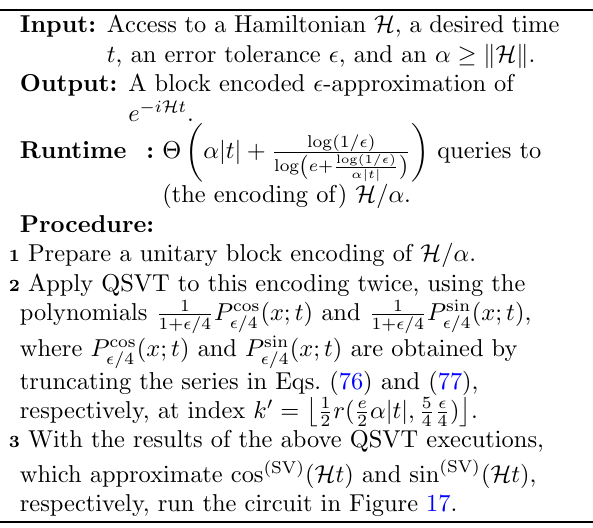
Algorithm 4. Hamiltonian Simulation by